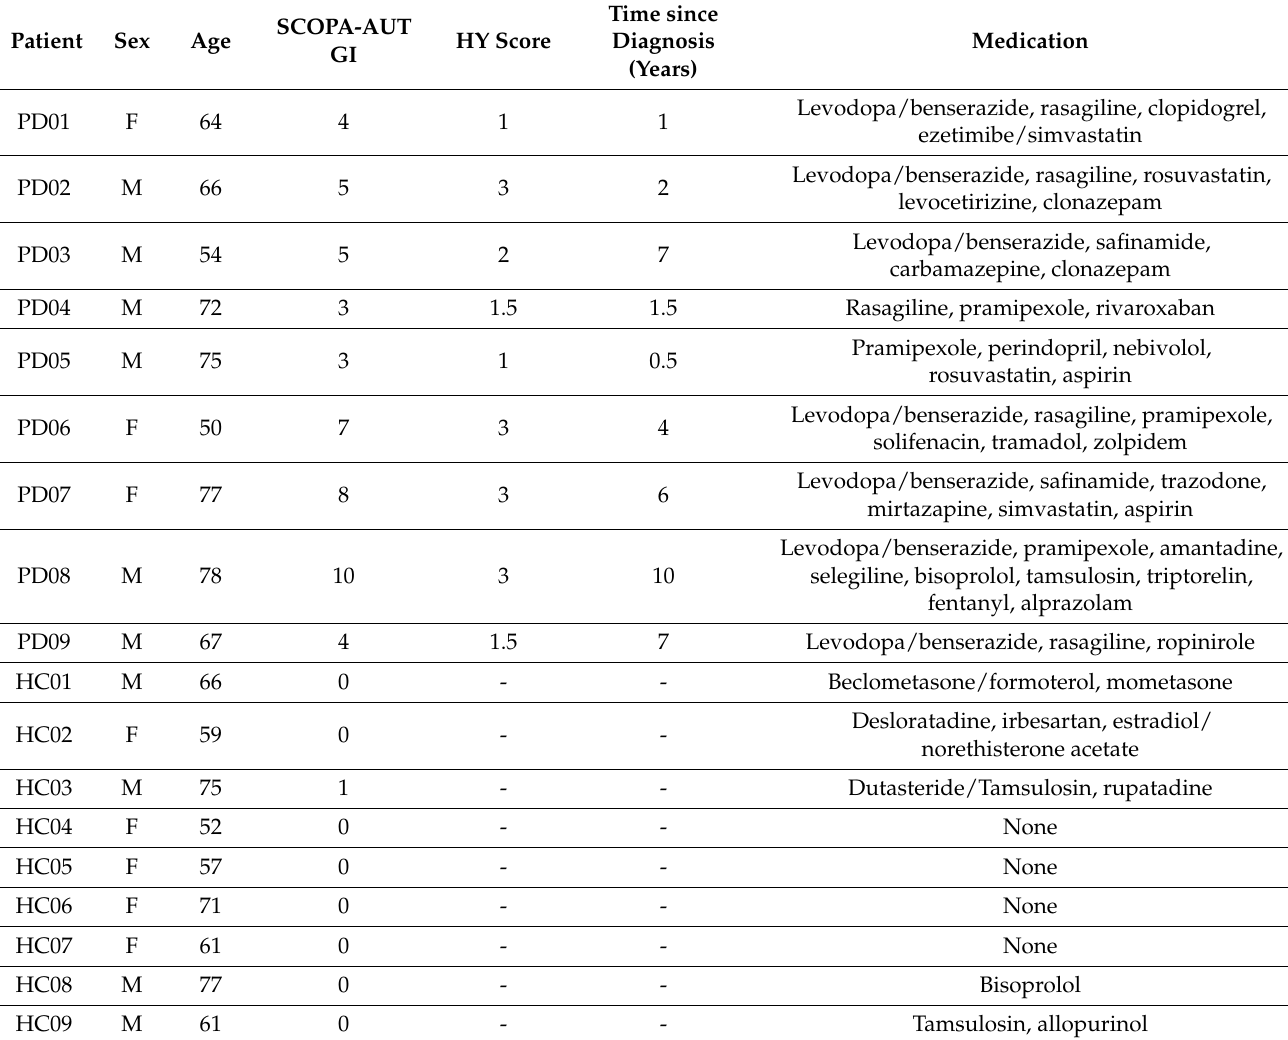
Table 1. Patient